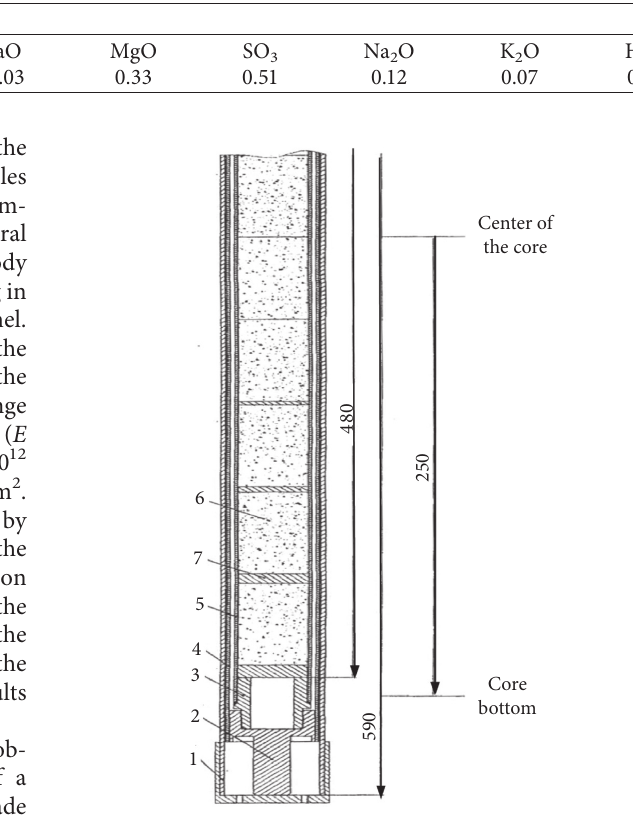
Figure 1: Irradiation device (dimensions are in mm): 1: «wet» channel body, 2: irradiation device shank, 3: ampoule shank, 4: irradiation device body (diameter 28 mm, wall thickness 1mm), 5: ampoule body (diameter 25mm, wall thickness 1mm), 6: material sample, and 7: washer.